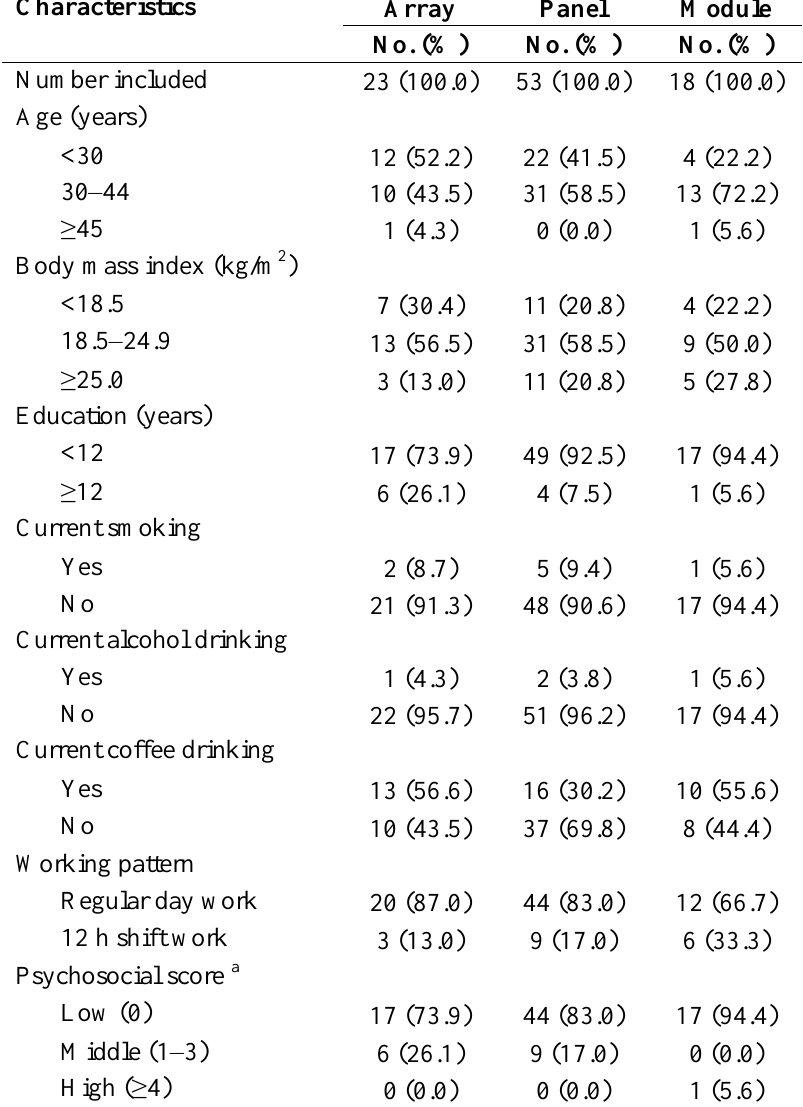
Table 2. Distributions of demographic and life style characteristics in female workers by three areas of fabrication.